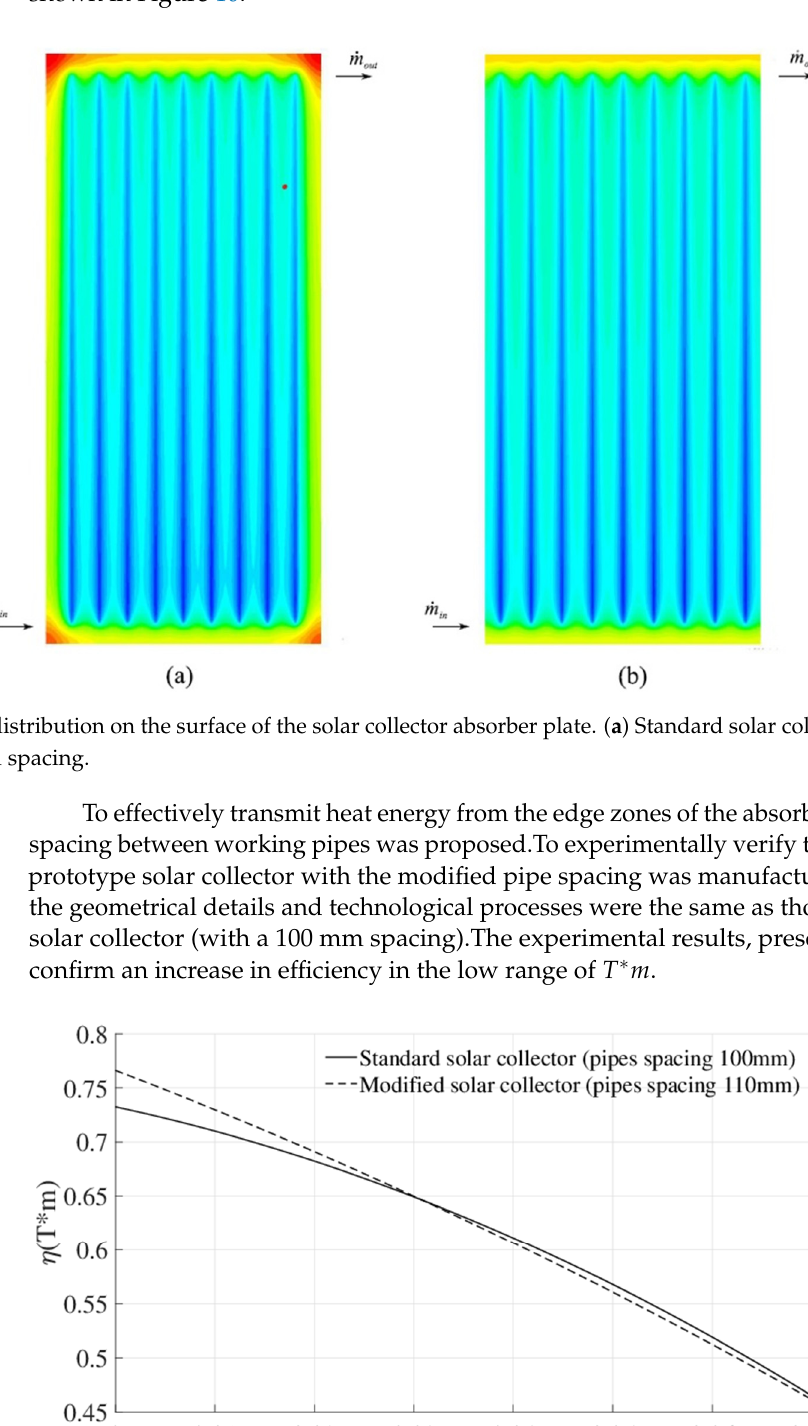
Figure 9. Experimental verification of the correlation between the changes in the thermal efficiency (cid:2015)((cid:1846) ∗ (cid:1865)) and the number of working pipes in the solar collector.